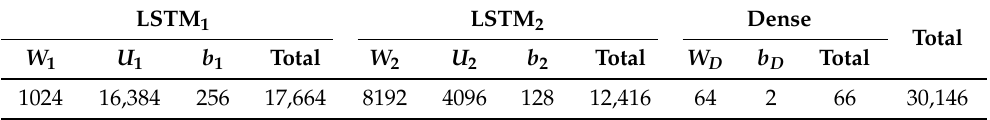
Table 3. [LHC] Sizes of tensors containing the model